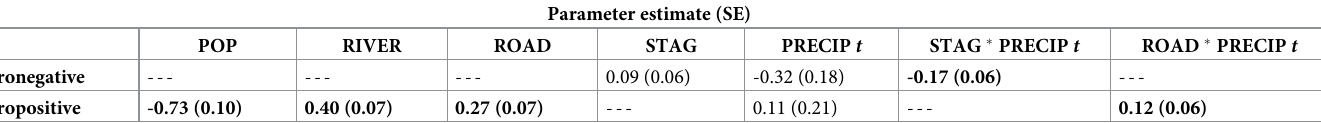
Table 4. Parameter estimates and standard errors (SE) for the environmental covariates featured in the top-ranking models describing the resource selection of deer that were seronegative and seropositive for Jamestown Canyon virus, Cook County, Illinois (1996–1999). Significant parameters ( α = 0.05) are in bold type